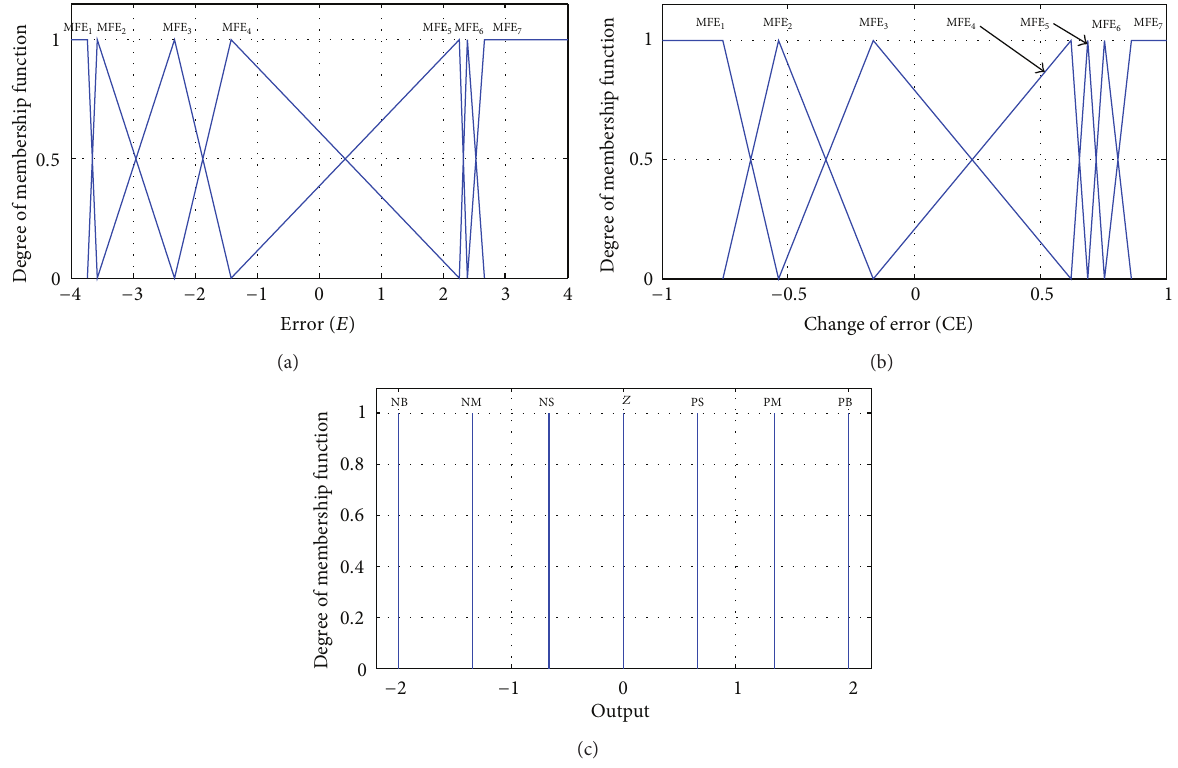
Figure 11: MF of the (a) 𝐸 , (b) CE, and (c)